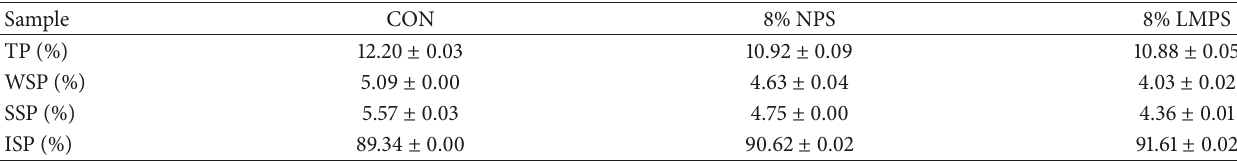
Table 1: Protein composition of surimi gel samples.